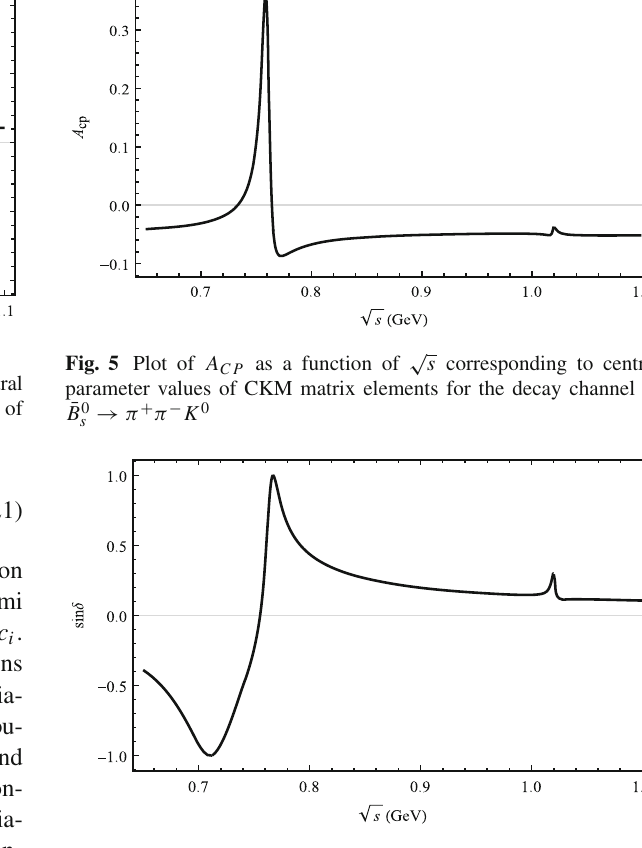
Fig. 6 Plot of sin δ as a function of parameter values of CKM matrix elements for the decay channel of ¯ B 0 → π + π − K s